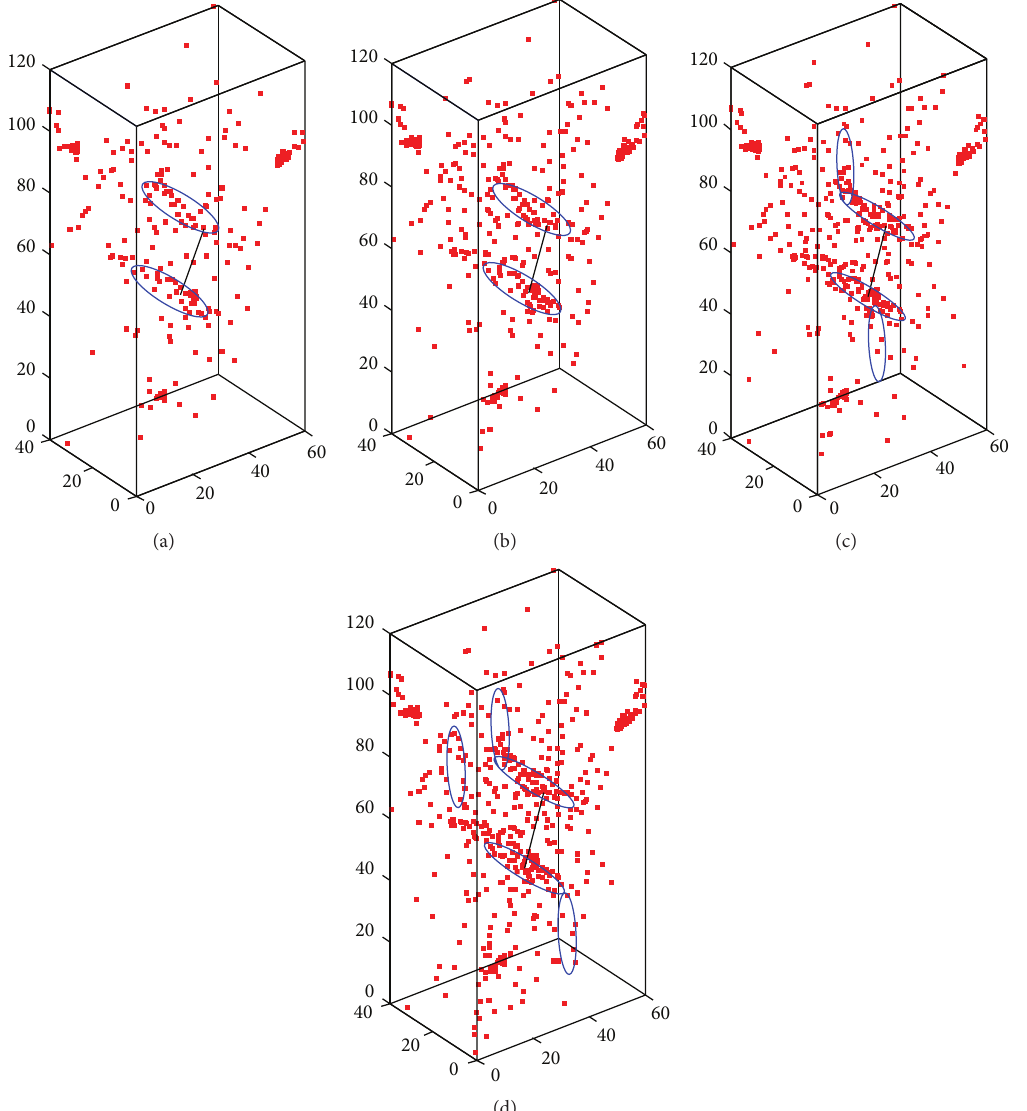
Figure 8: Positions of AE events of specimen E for different loading stages. (a) 𝜎 = 30 % 𝜎 𝑠 . (b) 𝜎 = 60 % 𝜎 𝑠 . (c) 𝜎 = 80 % 𝜎 𝑠 . (d) 𝜎 = 100 % 𝜎 𝑠